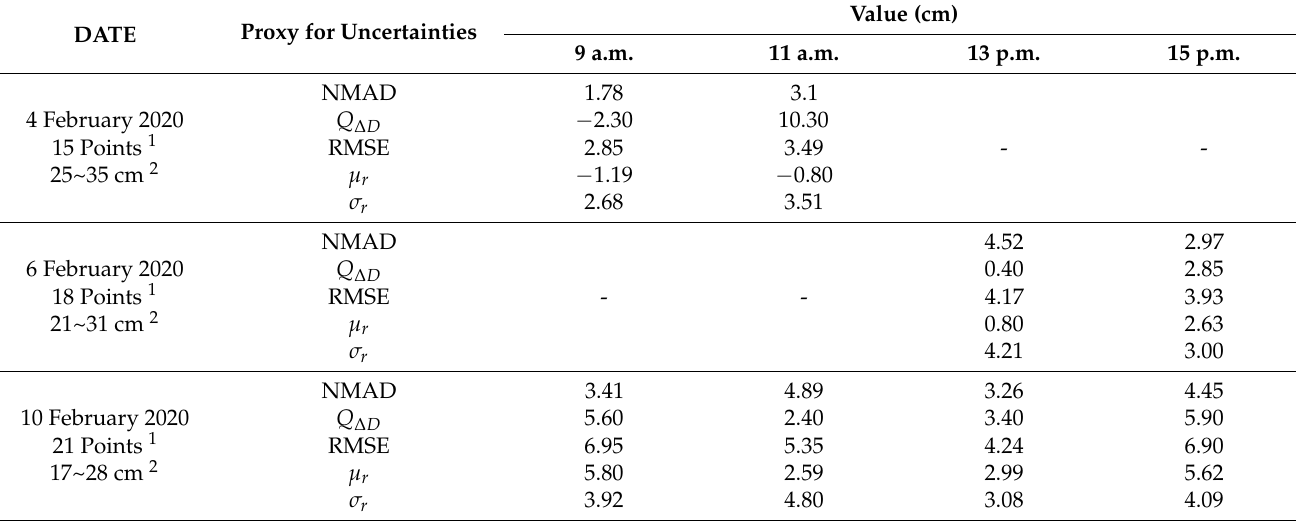
Table 4. Proxy for uncertainties of the eight surveys performed at optimal condition (50 m flight altitude and 80% overlap). Proxy for